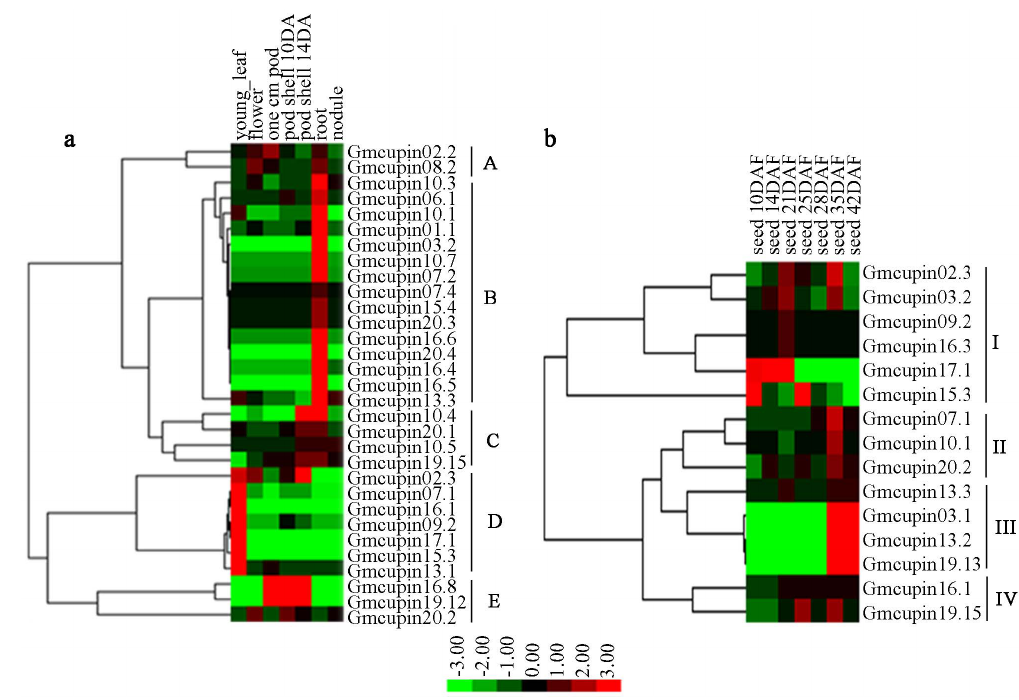
Figure 5. Expression profiles of 35 expressed Gmcupin genes in different tissues. a. Heatmap showing hierarchical clustering of 35 expressed Gmcupin genes among various tissues analyzed. b. Heatmap showing hierarchical clustering of 35 expressed Gmcupin genes during the development of soybean seeds.